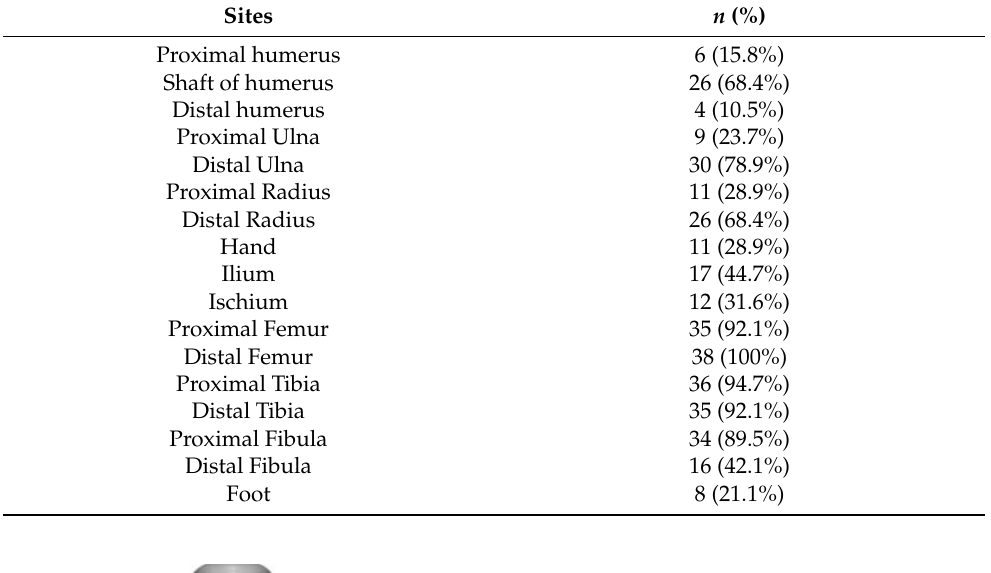
Table 4. Distribution of involved anatomical sites.